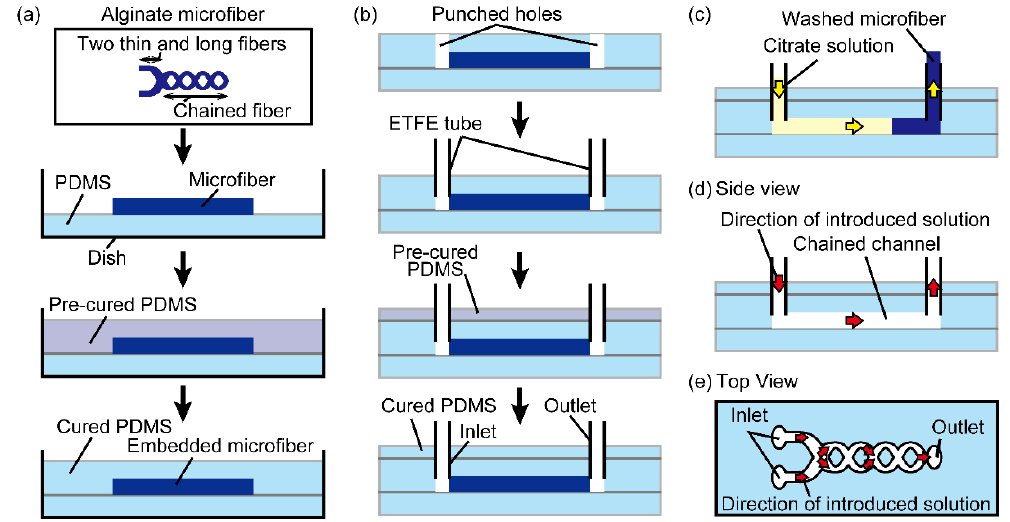
Figure 3. Process flow of the fabrication of chained PDMS microchannels. ( a ) Embedding of a microfiber with structure that two thin and long fibers are connected to a chained fiber into the PDMS substrate; ( b ) fabrication of inlets and an outlet for the microchannel; ( c ) removing the embedded microfiber; ( d ) side view of the formed microchannel; ( e ) top view of the formed microchannel.